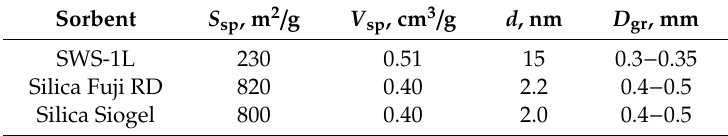
Table 6. Textural characteristics of the sorbents tested.